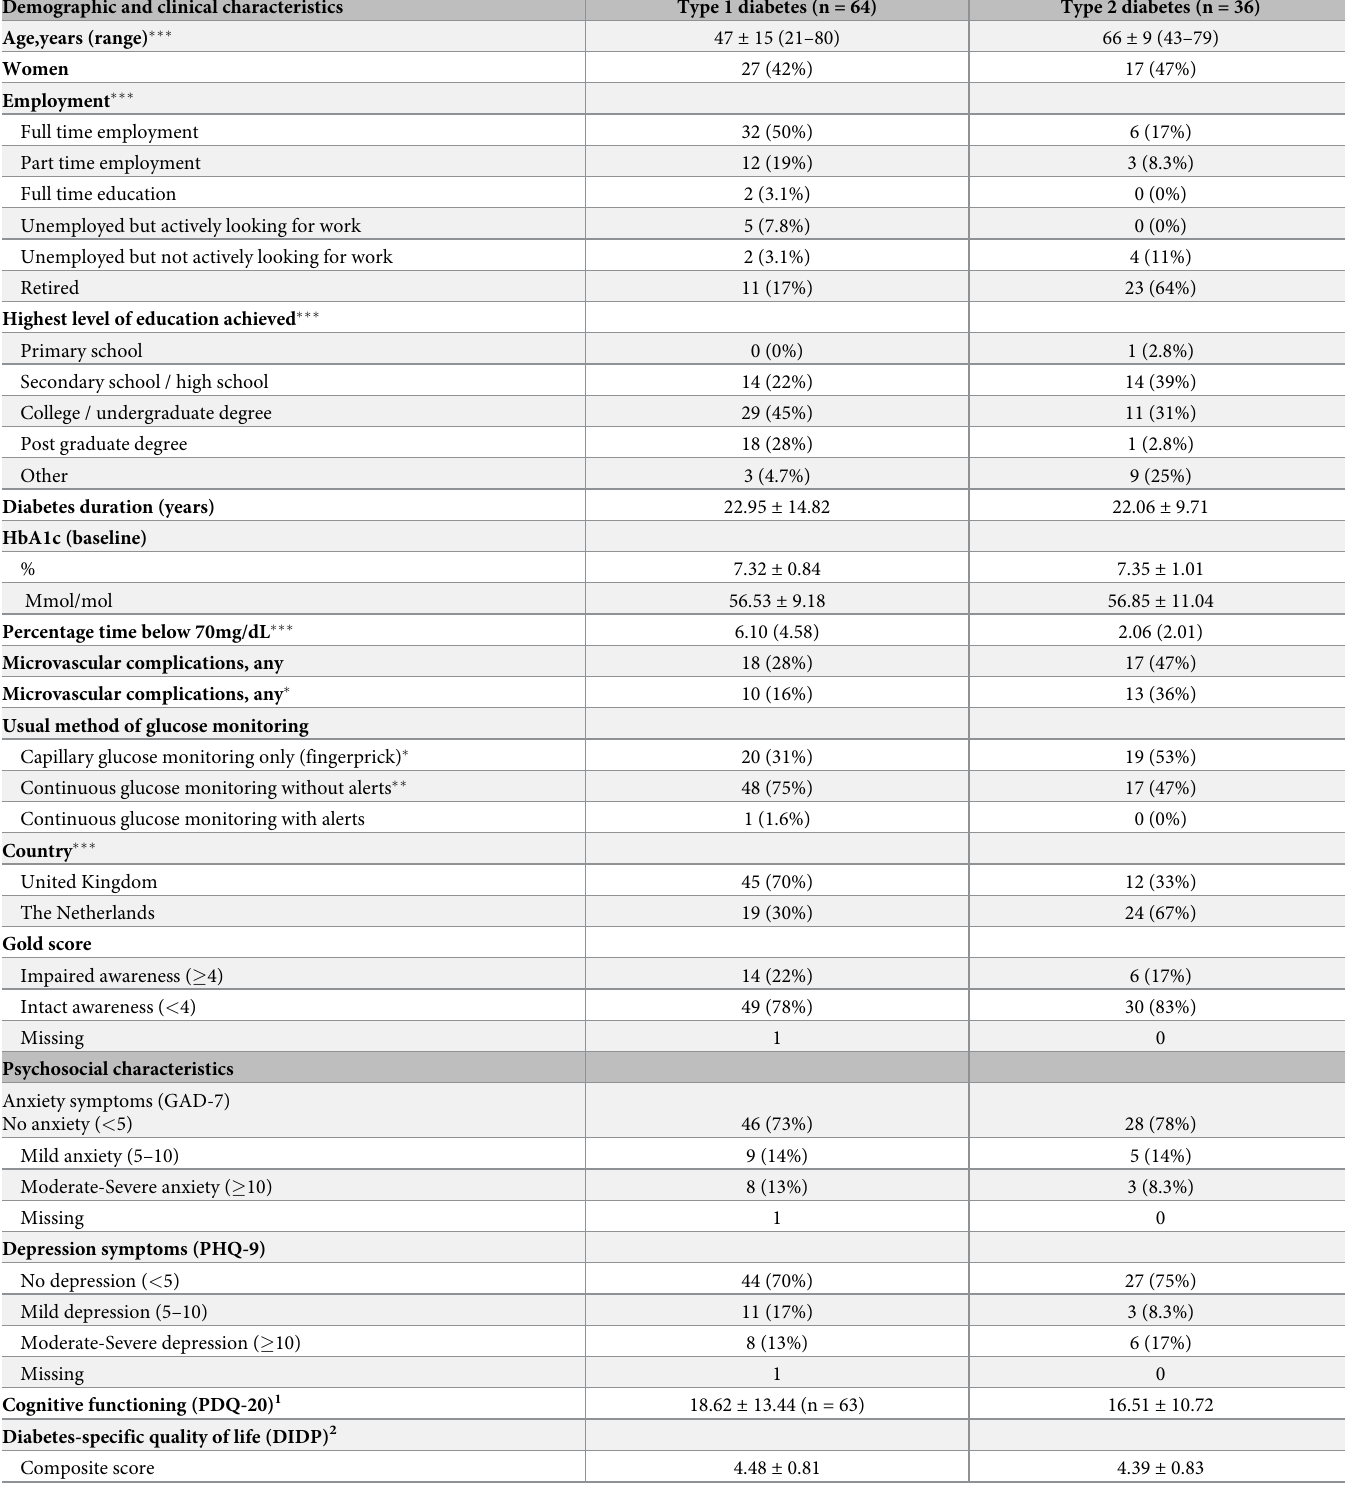
Table 2. Participants’ demographic, clinical and psychosocial characteristics at baseline (N =